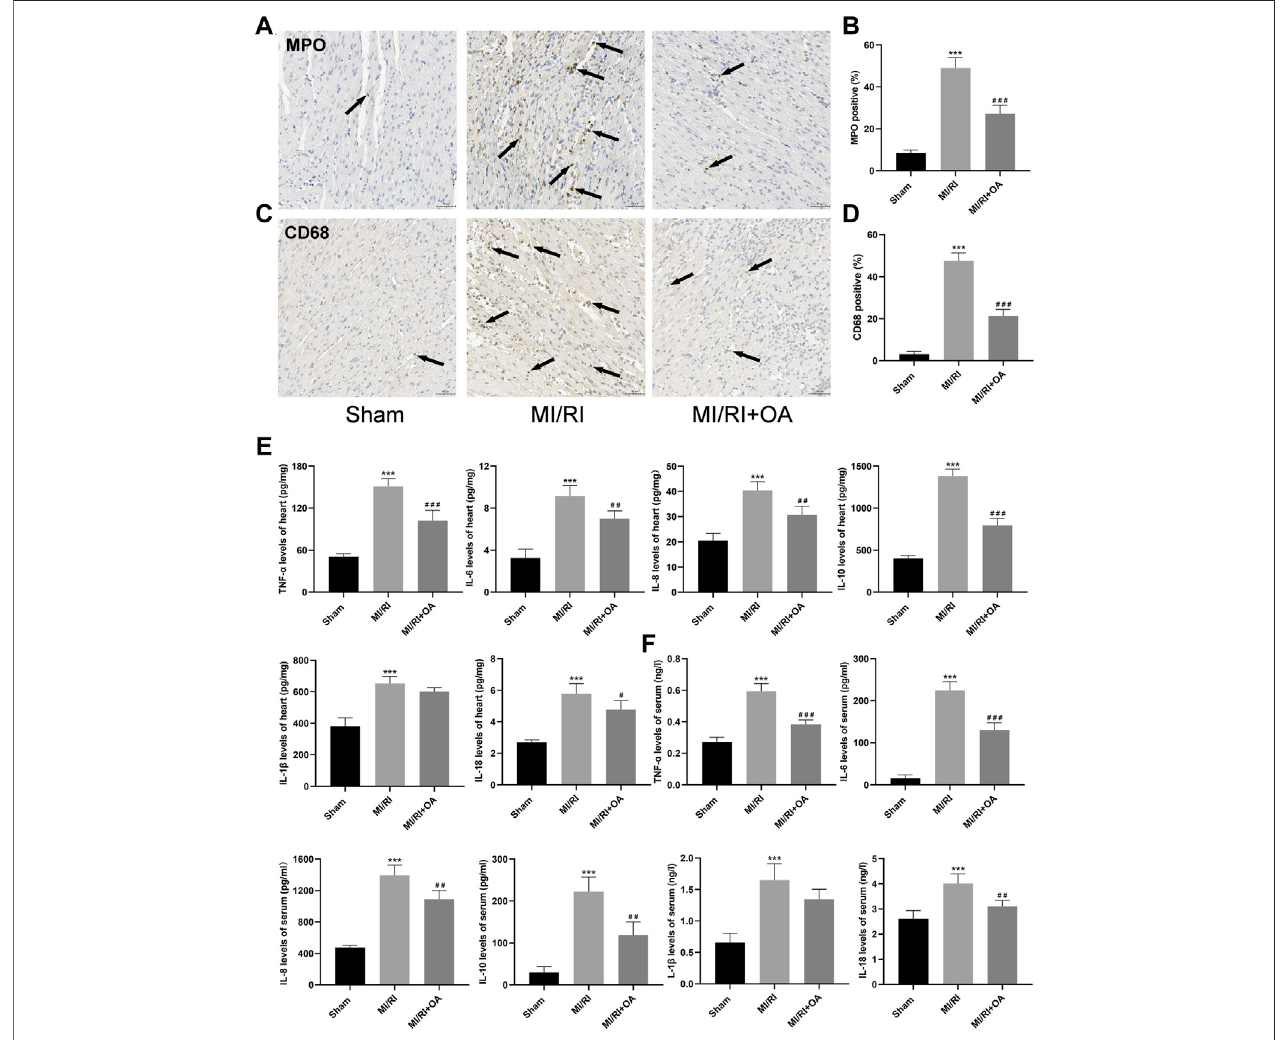
FIGURE8| OA treatment attenuates MI/RI induced in fl ammation in vivo (A – D) Representative IHC images and quantitative analysis for MPO and CD68 in each group (scale bar = 50 μ m). Arrows indicate representative neutrophil and macrophagocyte in fi ltrations (E,F) ELISA results showing that levels of TNF- α , IL-6, IL-8, IL-10, IL-1 β and IL-18 in the heart and serum in each group. Data are presented as the mean ± SD. ppp p < 0.001, compared with the Sham group; # p < 0.05, ## p < 0.01, ### p < 0.001, compared with the MI/RI group. MI/RI: myocardial ischemia/reperfusion injury; OA: Oroxin A; MPO: myeloperoxidase; ELISA: enzyme-linked immunosorbent